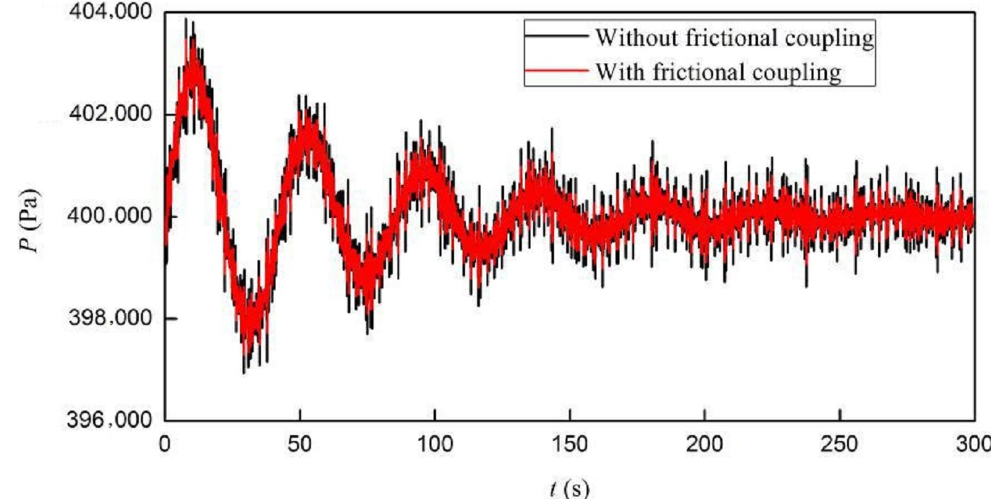
Figure 13. Time history of pressure at the bottom of surge chamber with and without frictional